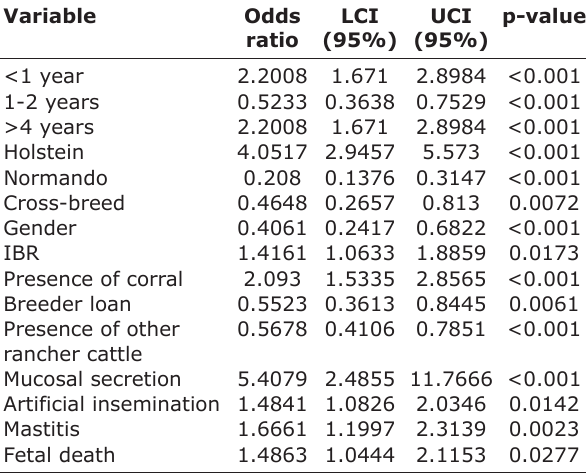
Table-7: Analysis of variables as possible risk factors associated with BLV infection.